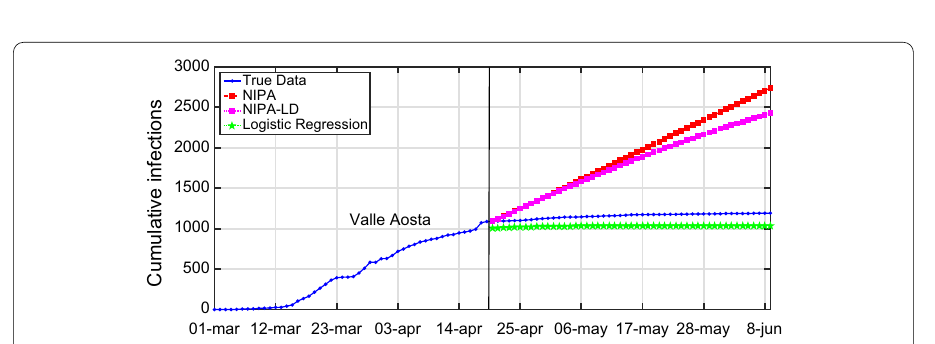
Fig. 16 Cumulative infections for Valle d’Aosta with n neglect =